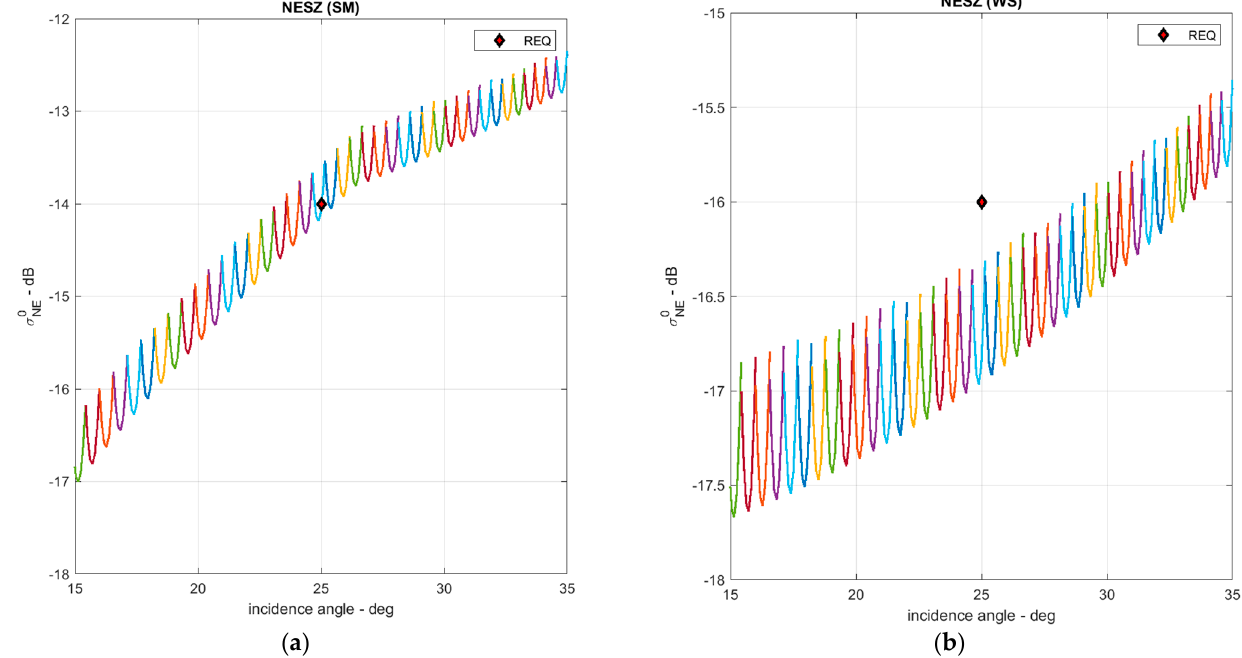
Figure 24. NESZ of the S-STEP SAR payload in the ( a ) high-resolution and ( b ) wide-swath modes. NESZ is lower than the required level of − 14 and − 16 dB at an incidence angle of 25° for the high-resolution and wide-swath modes, respectively. Each color shows the corresponding swath.